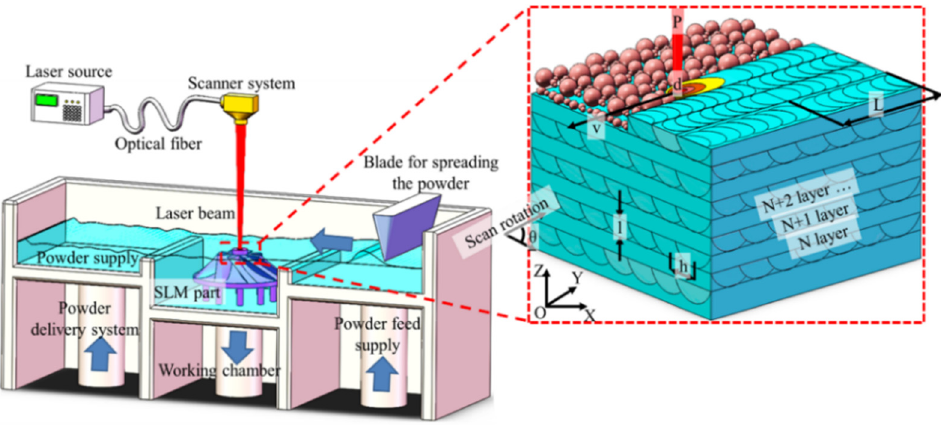
Figure 1. Schematic diagram of selective laser melting. Reprinted with permission from ref. [6]. Copyright 2020 Springer Nature.